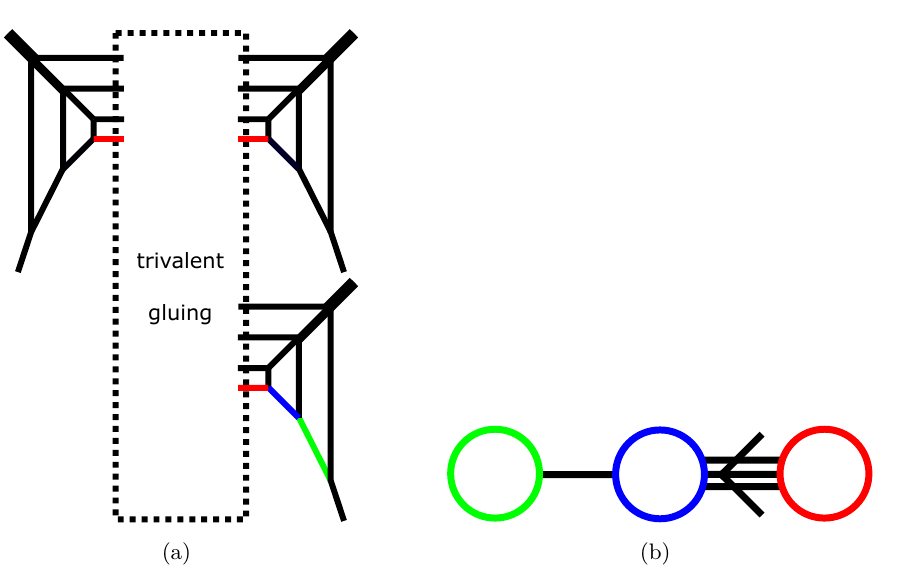
Figure 13. (a): The web diagram of the theory obtained after the Higgsing (3 , 3 , 3) . (b): The Dynkin diagram of the twisted affine Lie algebra so (8) (3) which is formed by the colored lines in figure 13(a). The lines in red, blue and green in figure 13(a) correspond to the nodes in red, blue and green in this figure respectively.